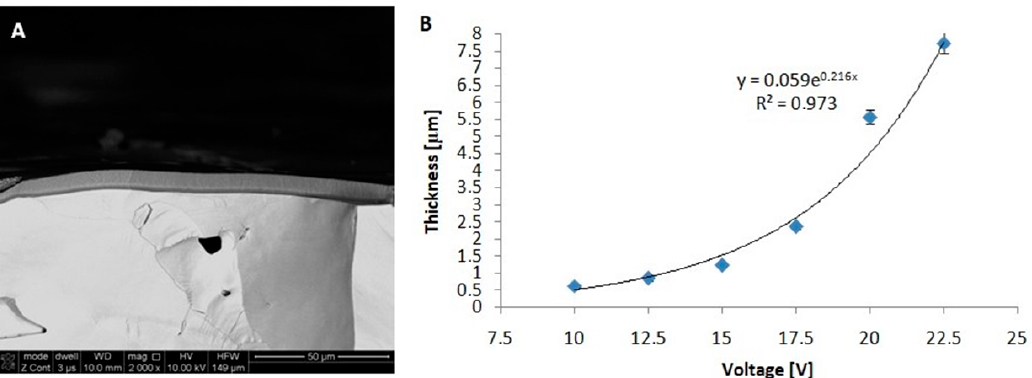
Figure 4. Cross-sectional FE-SEM image of the anodic oxide formed by self-organized anodization of the FeAl 3 intermetallic alloy in 20 wt% H 2 SO 4 at 22.5 V ( A ) and the thickness of the oxide layer as a function of the anodizing voltage ( B ).